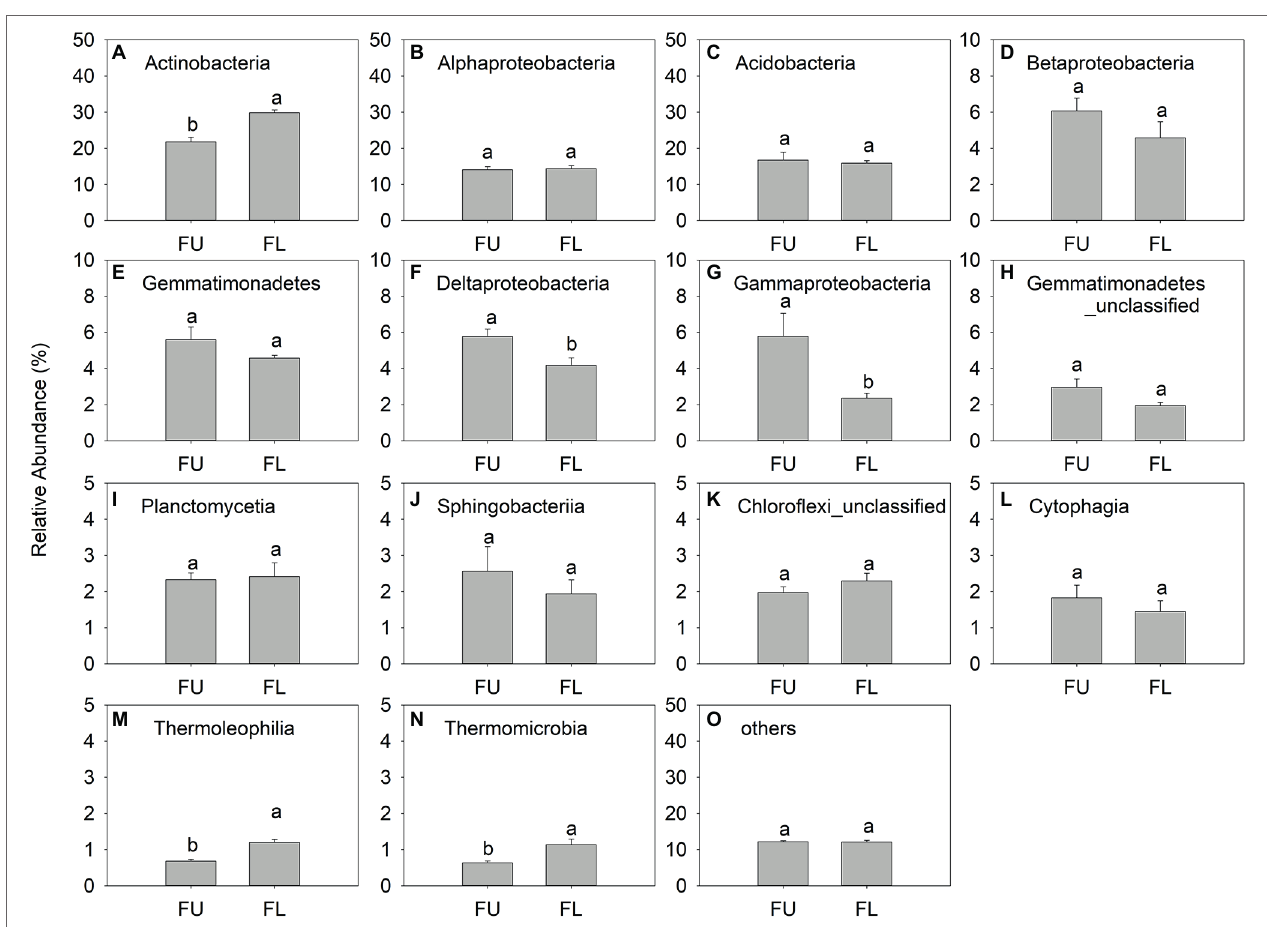
FIGURE 7 | Relative abundance (% of individual taxonomic group) of dominant bacteria classes (mean ± SE, n = 4) in microbial communities following FU and FL. (A-O) represented different soil bacterial at class level. Different lowercase capital letters indicate statistically significant difference among communities at p =